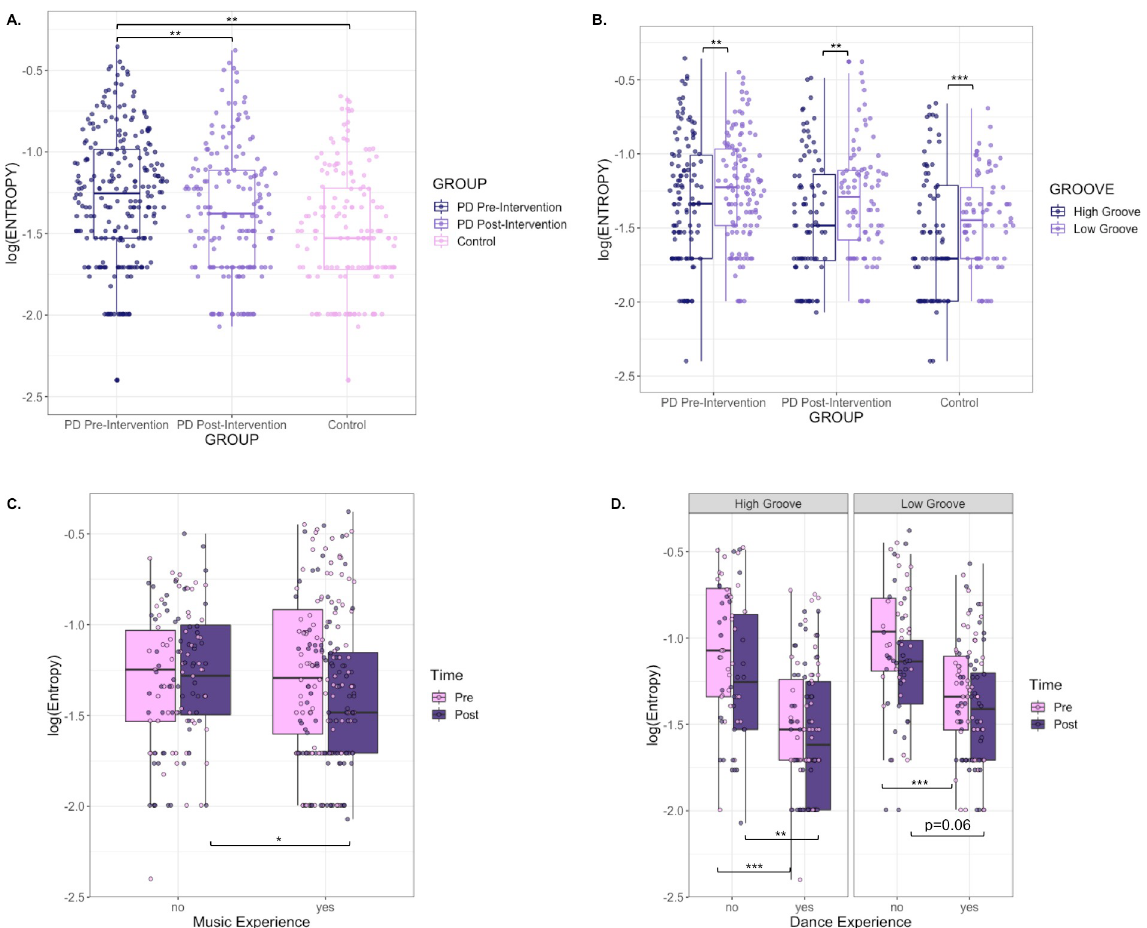
Fig 5. A. Comparison of log(Entropy) values for pre-intervention PD participants, post-intervention PD participants, and control participants. B. Fig 4A by groove. C. Log(Entropy) values by time of testing and music experience. D. Pre- and post-intervention log(Entropy) values separated by groove, time of testing, and dance